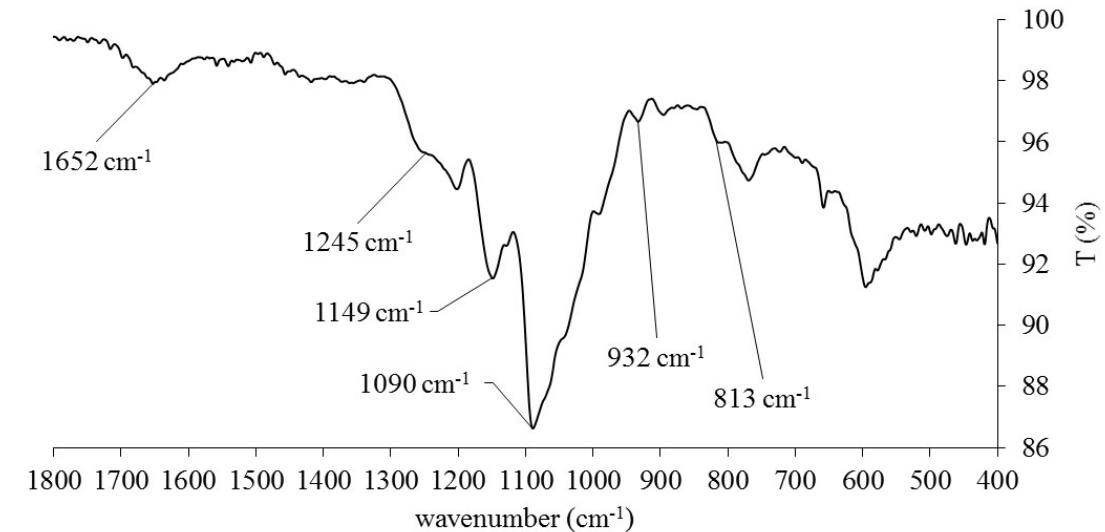
Figure 2. Close-up of the ATR-FTIR spectrum of the solid porphyran-enriched Figure 2 Close-up of the ATR-FTIR spectrum of the solid porphyran-enriched extract.